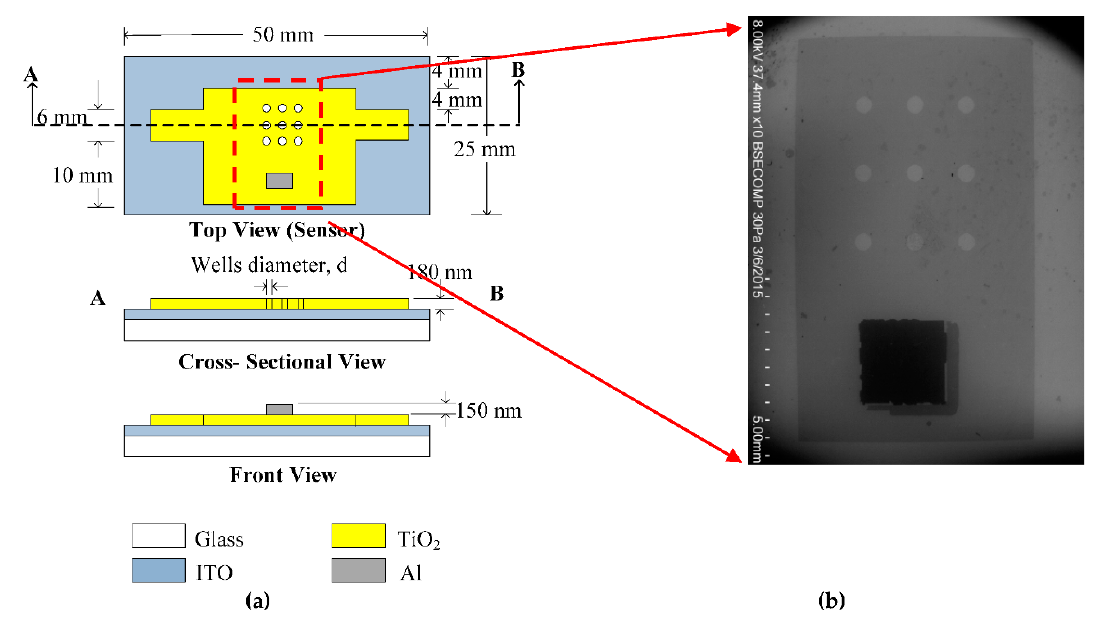
Figure 3. Schematic diagram of sensing platform; and ( a ) image of fabricated sensor ( b ).